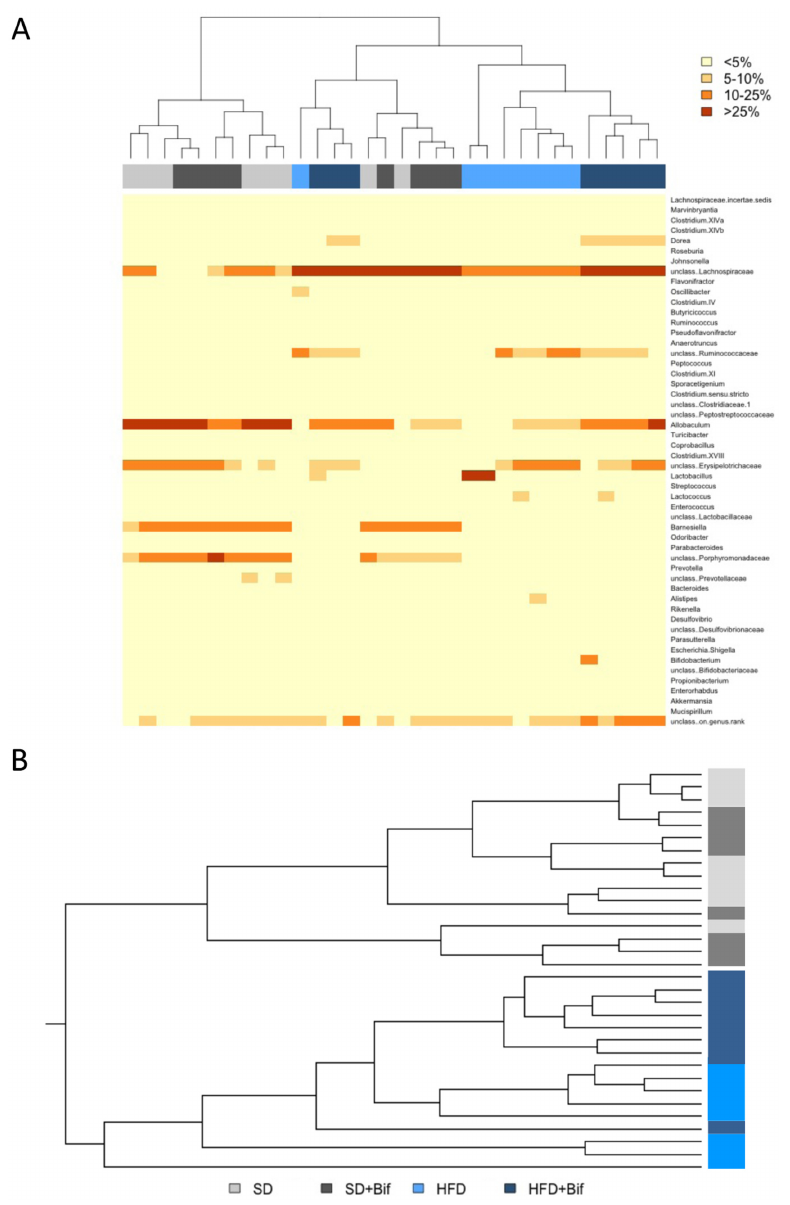
Fig 7. Cluster analysis of the fecal microbiota composition determined by pyrosequencing in different mouse groups after 14 weeks of dietary intervention. Mouse group affiliation is indicated in light-grey and dark-grey for the SD group and the SD+Bif group and light-blue and dark-blue for the HFD group and the HFD +Bif group mice, respectively. A: Heatmap of Bray-Curtis distances of 52 genera with abundances of at least 0.1% in at least one sample. Abundances are categorized in four classes: below 5%, 5 to 10%, 10 to 25% and above 25% of the sequence reads. B: Cluster dendrogram of the weighted UniFrac analysis of 1254 phylotypes with more than 10 reads in all samples of the four